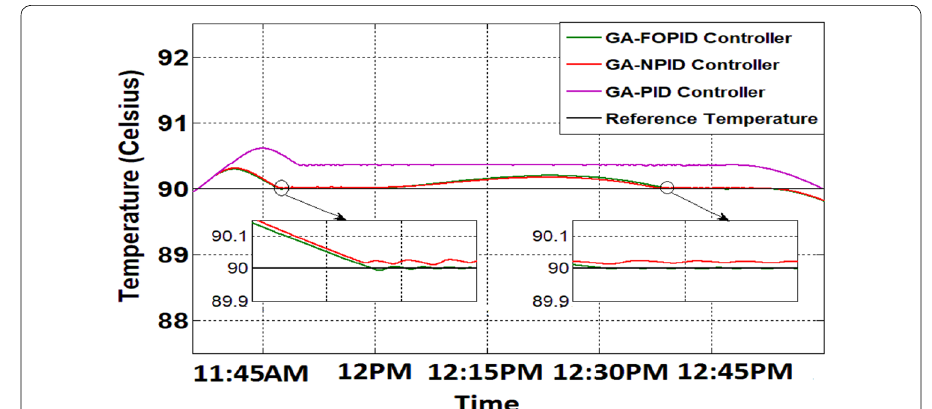
Fig. 10 Temperature response using GA-PID controller, GA-NPID controller and GA-FOPID controller